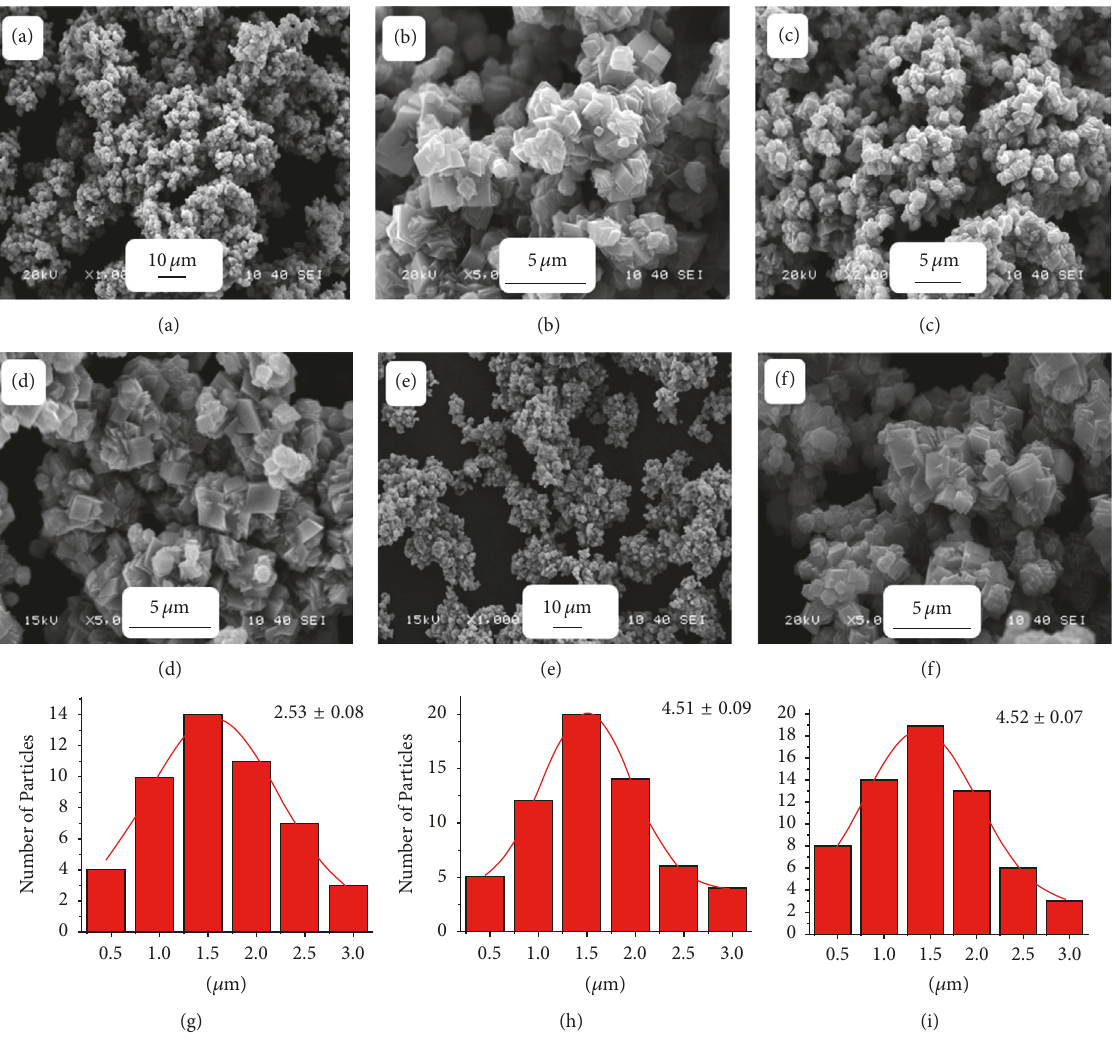
Figure 1: SEM analysis of the catalysts calcined at (a)-(b) 300 ∘ C; (c)-(d) 400 ∘ C; (e)-(f) 500 ∘ C; (a)-(b) overview image for as-prepared 1% ZnO –MnCO 3 ; (c)-(d) overview image of 1% ZnO x ZnO –MnCO 3 ; (h) particle size distribution of 1% ZnO x